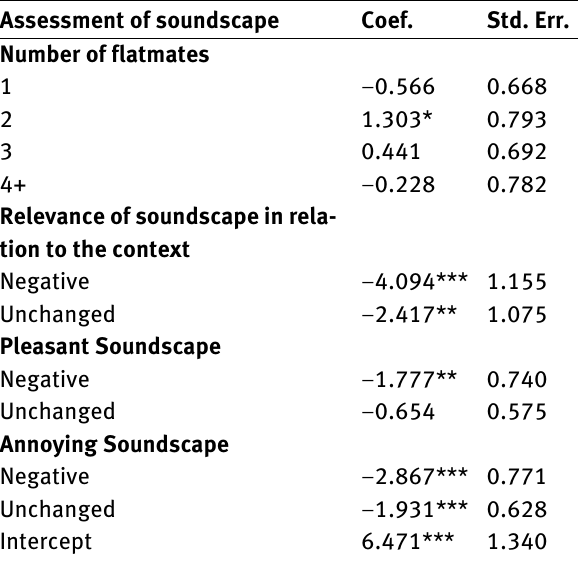
Table 19: Coeflcients of the model for the assessment of sound- scape Assessment of soundscape Coef. Std. Err.